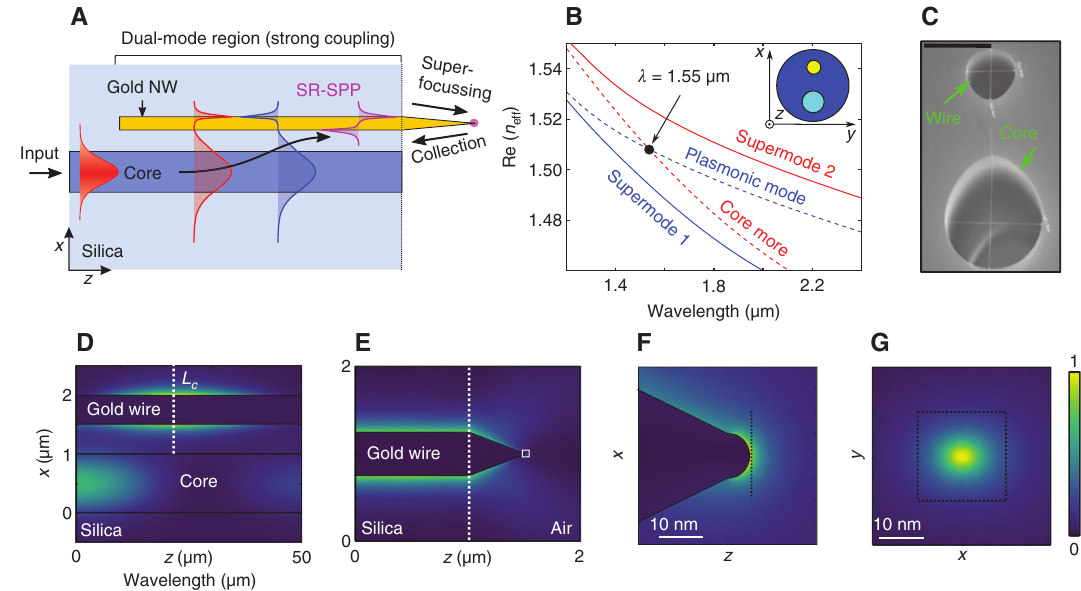
Figure 7: Simulated characteristics of the fiber-based hybrid plasmonic directional coupler. (A) 2D scheme of the couplers including all relevant modes. The dielectric core mode excites two hybrid EMs in the dual waveguide region, which propagate and beat to excite an SR-SPP after a defined propagation length at the end of the device that is nanofocused using the tip. (B) Real part of the effective indices of the hybrid modes of a fiber-based plasmonic directional mode coupler for the excitation of the RP plasmonic mode on the nanowire (core diameter: 1 μ m, wire diameter: 0.5 μ m, edge-to-edge separation: 0.5 μ m, light blue: